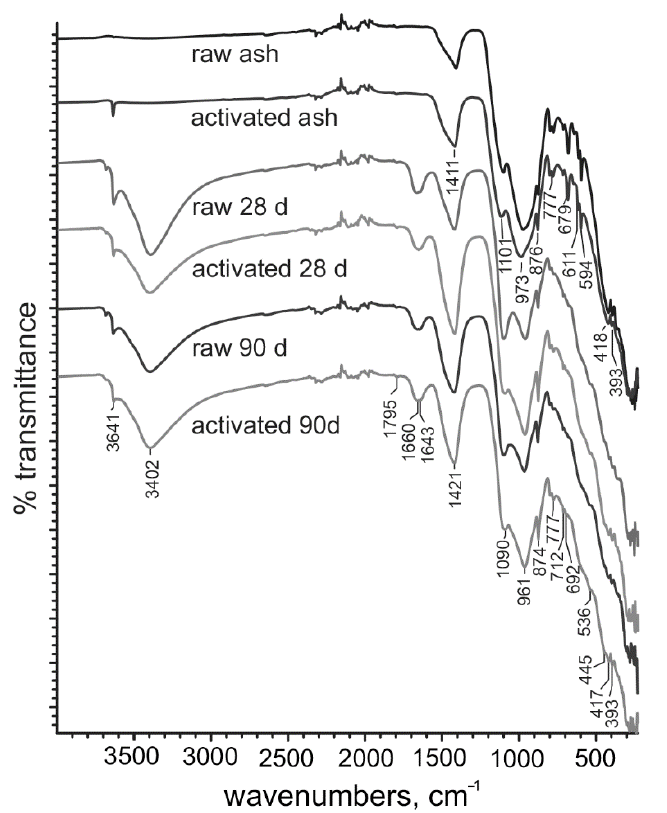
Figure 8. Representative ATR-FTIR spectra of raw and mechanically activated ash and ash pastes made with raw ash and activated ash (4 min) after 28 and 90 days of curing.